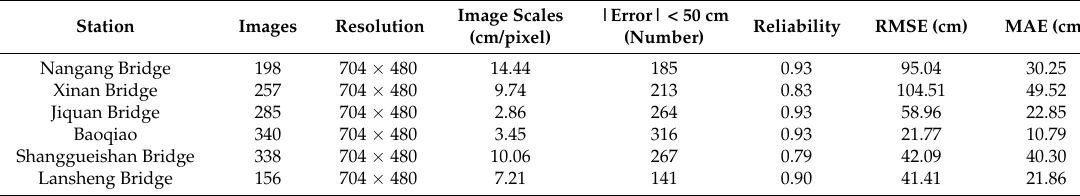
Table 2. Reliability analysis of image identification of typhoon Megi.